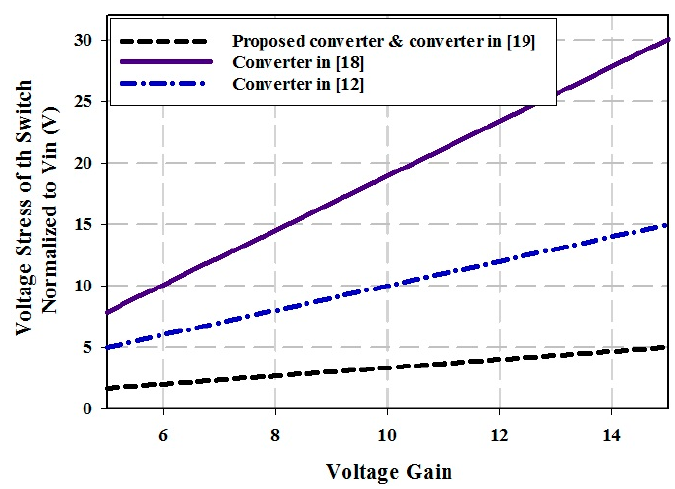
Figure 8. Voltage stress of the switch for different turn ratios of coupled inductors.